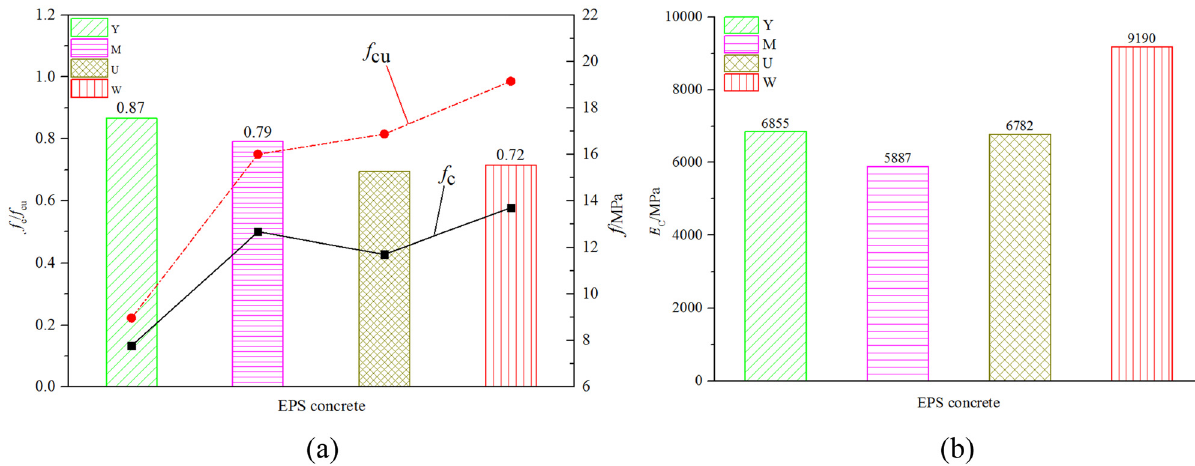
Figure 10: Strength and elastic modulus of test pieces: ( a ) specimen strength and ( b ) elastic modulus of the test piece.